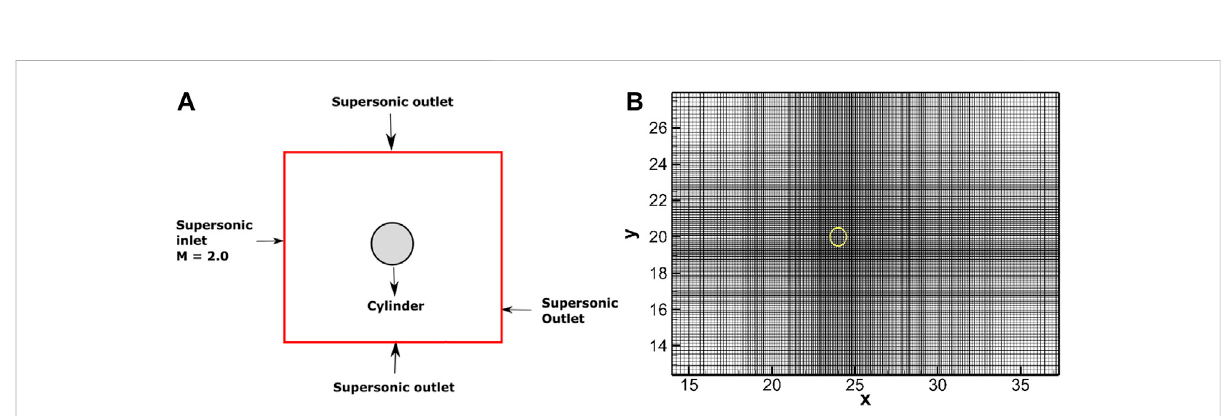
Figure 15. The solution of the present IB method is compared with the body- fi tted grid simulation by Swanson and Langer